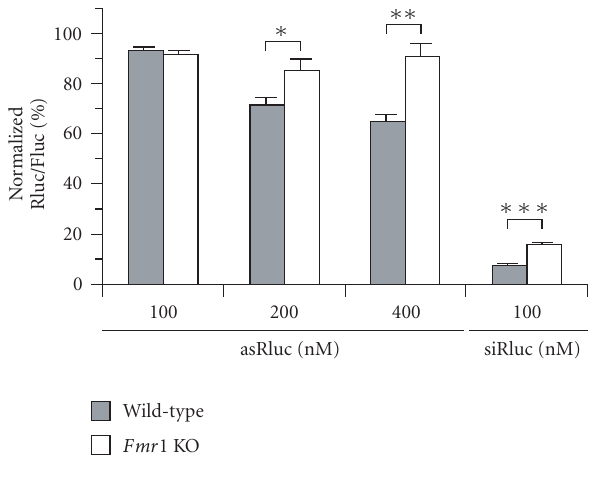
Figure 5: FMRP is required for ss siRNA-induced RNA silencing. Fmr1 KO (TSV-40) and wild-type (Na ¨ ıves) cells were cotransfected with ss antisense Rluc siRNA (asRluc) or Rluc siRNA duplex (siRluc) and psiCHECK reporter construct ( n = 6). Results were expressed as mean ± SEM and analyzed as described in the legend of Figure 4. ∗ P < . 05; ∗∗ P < . 01; ∗∗∗ P < .